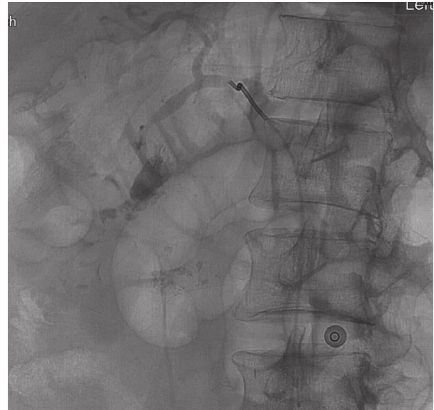
Figure 6: Contrast-enhanced image during the embolization.